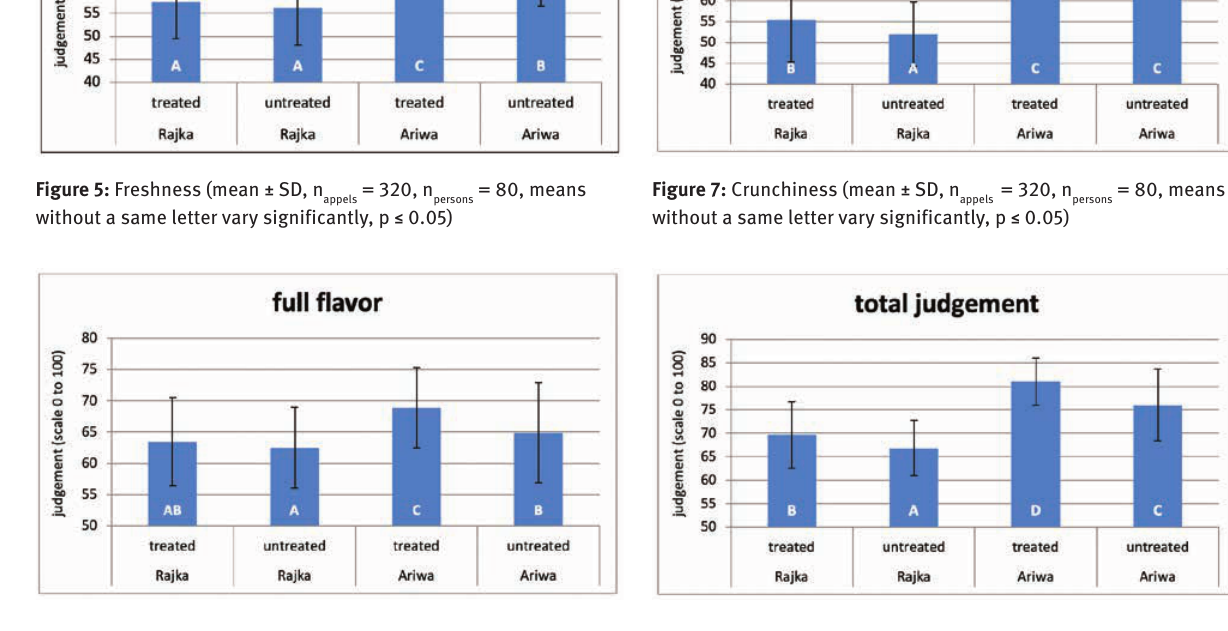
= 320, n = 80, appels persons